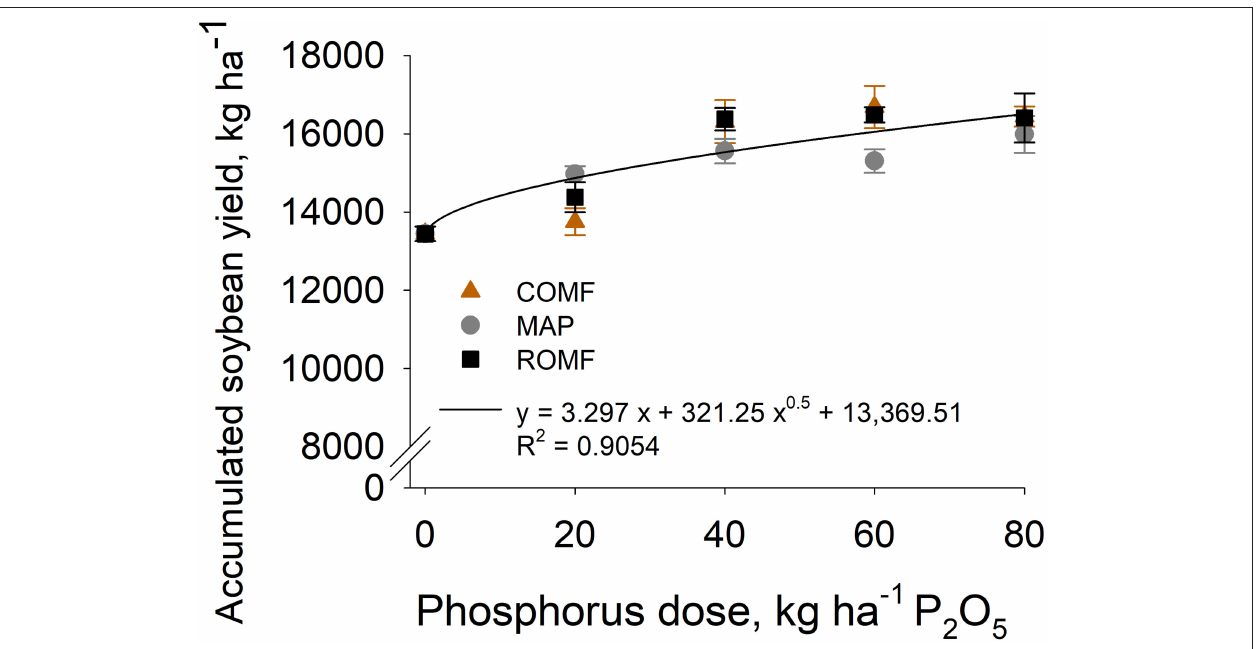
FIGURE 3 | Accumulated soybean grain yield from treatments with different fertilizers sources and P doses after five crop seasons (2010–2015). COMF, composted organomineral fertilizer; MAP, monoammonium phosphate; ROMF, raw poultry litter organomineral fertilizer.